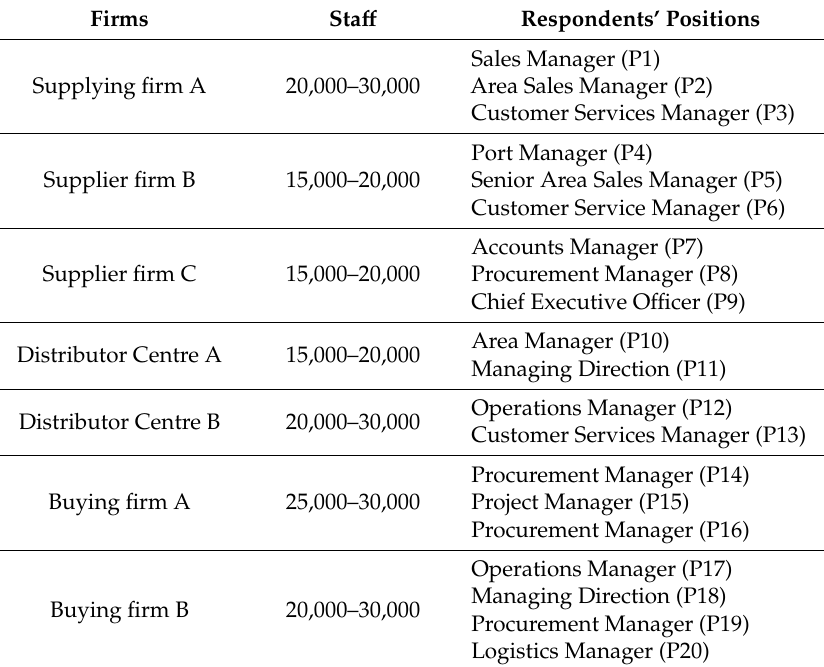
Table 1. Profile of